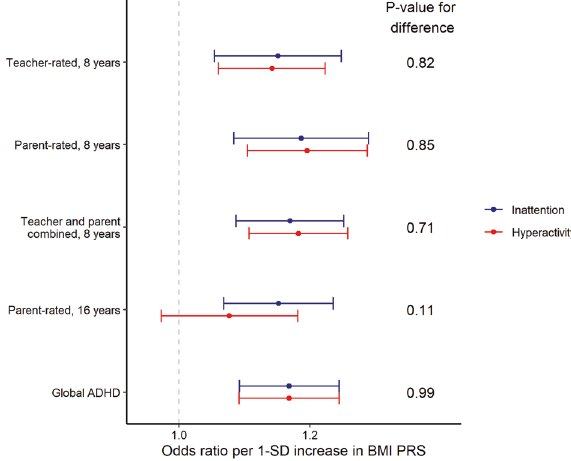
Fig. 3 Effect size estimates and their 95% con fi dence intervals per 1-standard deviation increase in BMI PRS on increasing number of ADHD symptom types according to rater and age. P values are for testing the difference between inattention and hyperactivity effect size